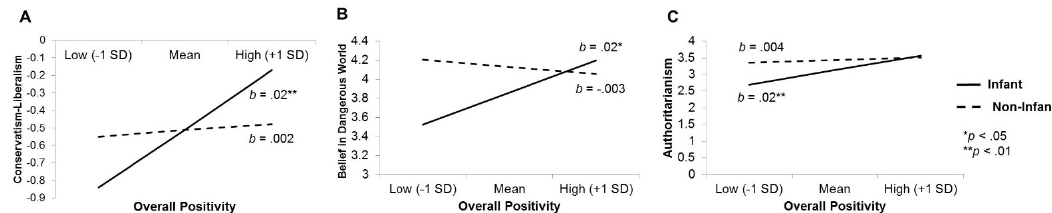
Figure 1. Interactions between the type of face participants viewed (infants or non-infants) and overall positivity (affiliative reactions) to the faces on worldviews and ideologies in Study 1. Among participants who were exposed to faces of infants, higher overall affiliative reactions were associated with increased: ( A ) Support for conservative (relative to liberal) values, ( B ) perceptions of a dangerous world, and ( C ) endorsement of right-wing authoritarianism. Note: Values for conservatism (relative to liberalism) are negative given that the sample overall endorsed stronger liberal values than conservative